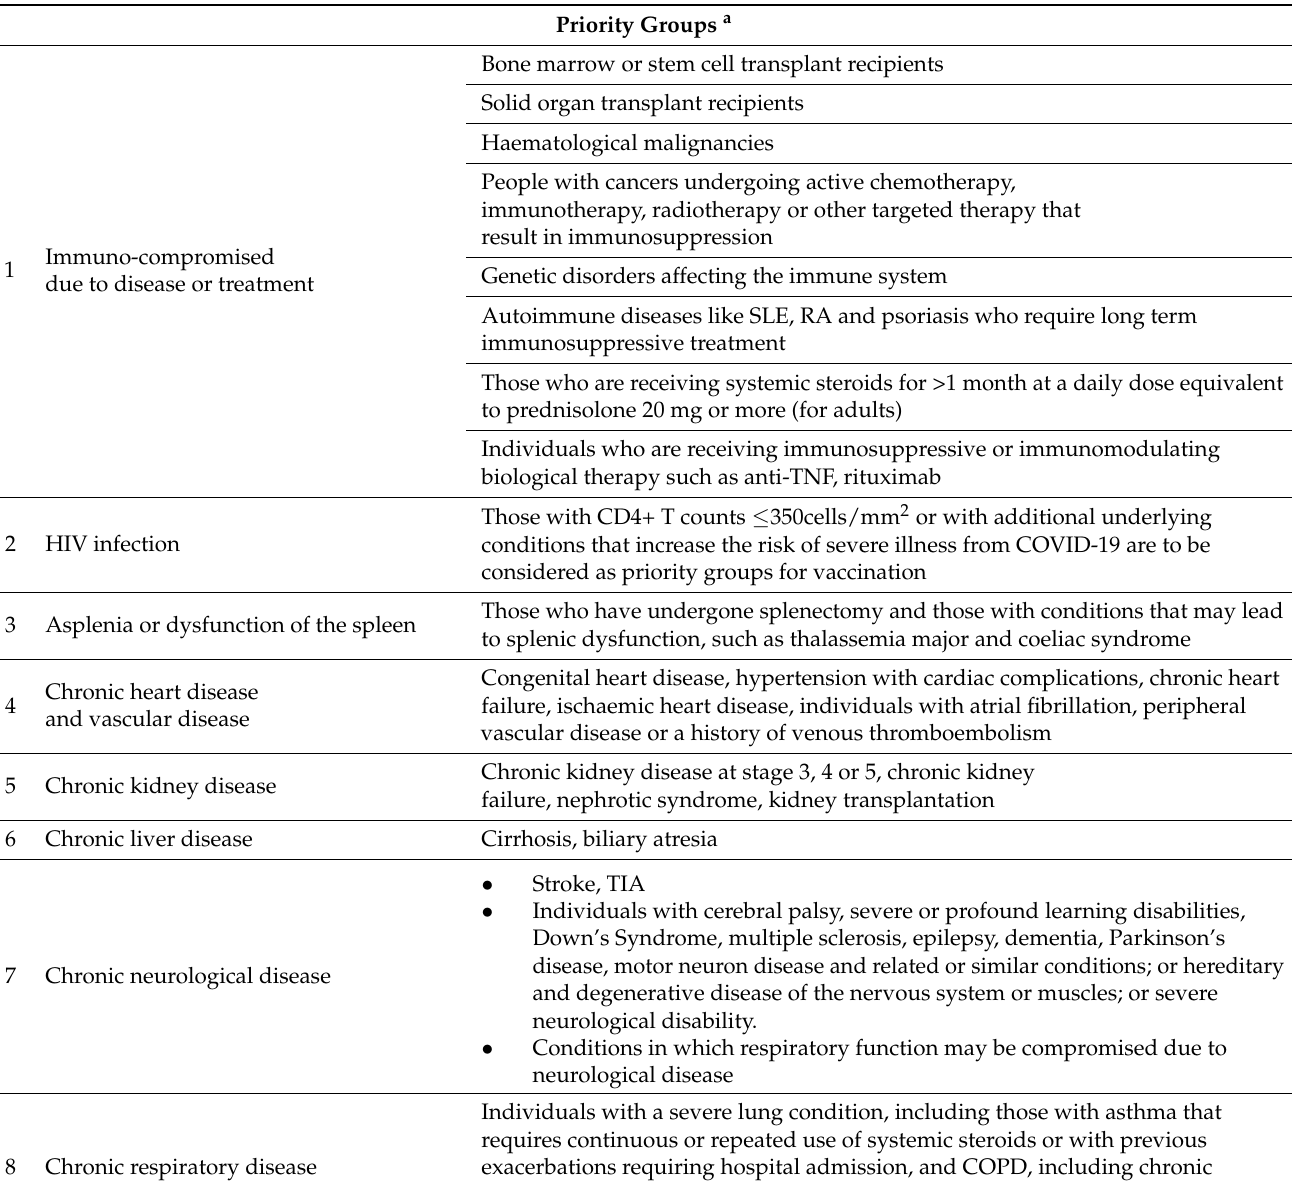
Priority Groups